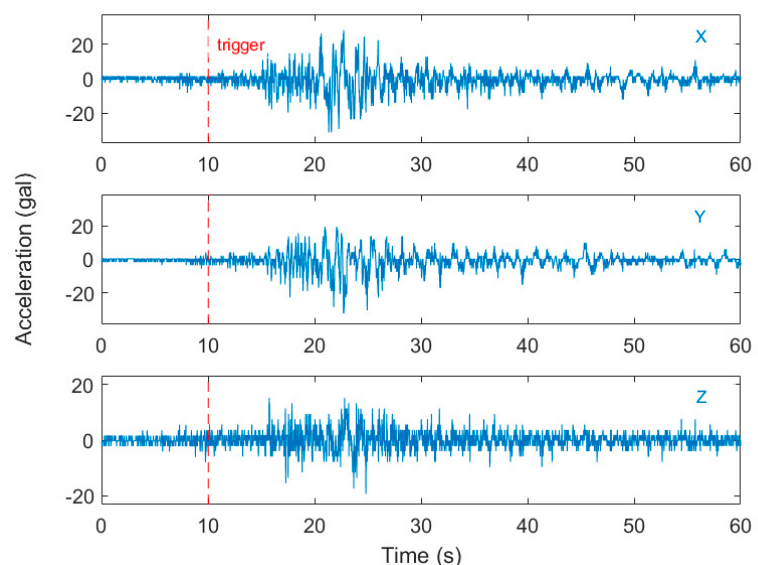
Figure 9. The typical case of false classification during the shake table test in the second dataset (Meinong earthquake). The PGA is only 27.8 Gals, i.e., just above the threshold to issue an alert (25 Gals).